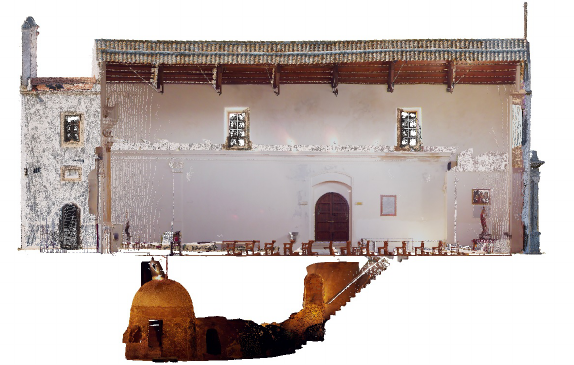
Figure 17. Section of the final 3D